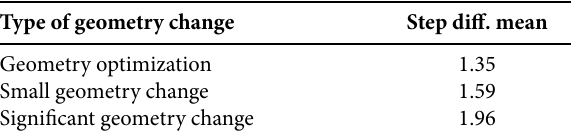
Table 7: Step difficulty means when interacting directly with the model, depending on the type of geometry change Type of geometry